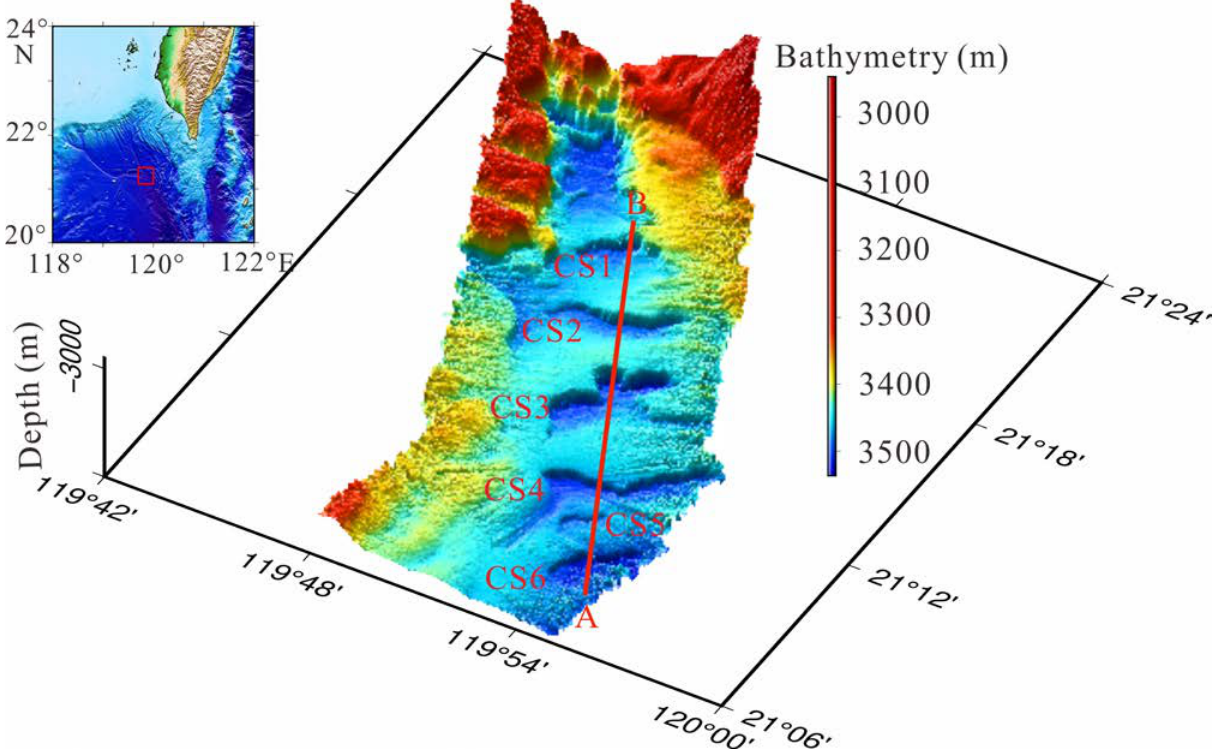
Figure 5. Three-dimensional topographic map of the cyclic steps. Six cyclic steps CS1–CS6 are located in the lower section of the Penghu canyon. The CS1–CS6 indicate the crescent shape and upstream migration. The red line (AB) is the profile line.